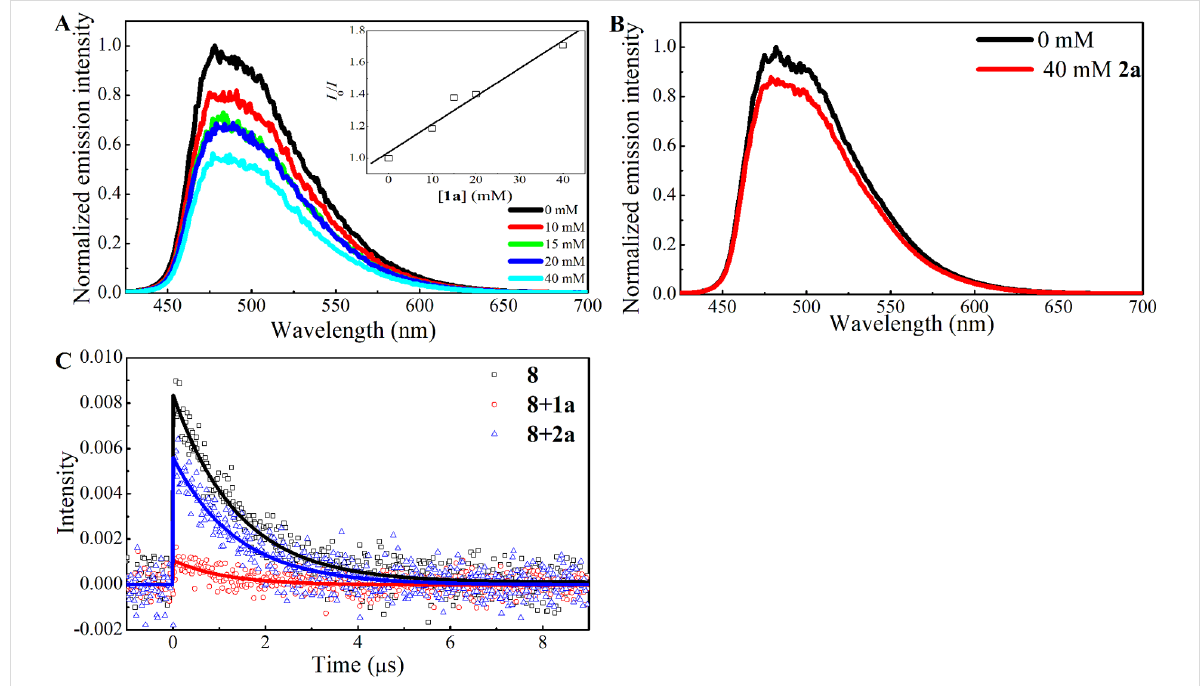
Figure 1: Photoluminescence (PL) spectra of the 3 MLCT state of 8 in degassed DMSO solvent with (A) various concentrations of xanthate 1a added and (B) 40 mM of 1-octene ( 2a ) added. The inset of (A) gives the Stern–Volmer plot of the corrected PL quenching at 480 nm. (C) Time-resolved PL lifetime decay profiles of photocatalyst 8 in degassed DMSO in the absence of quencher (square), presence of xanthate 1a (circle) and presence of 1-octene ( 2a , triangle). The mono-exponential decay fits are provided.